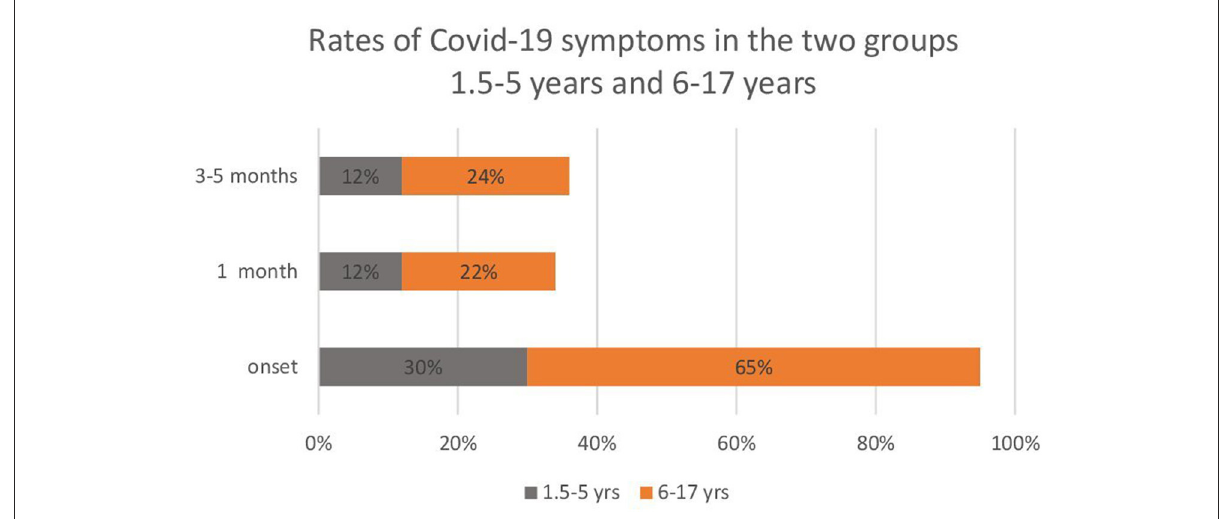
FIGURE1 Rates of COVID-19 symptoms in the two subgroups of paediatric patients: 1.5–5 years ( n = 50) and 6–17 years ( n = 272).